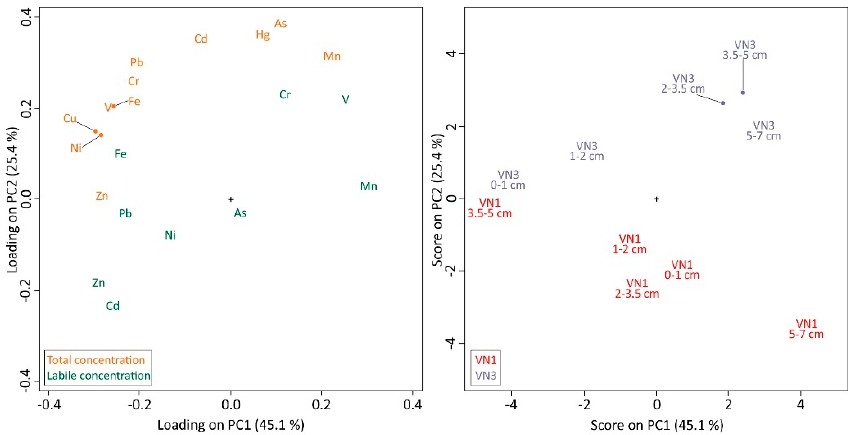
Figure 2. Score and loading plots resuming the results of principal component analysis (PCA) performed on total and labile metal(loid) concentrations is sediments at sites VN1 and VN3. Table 1. Metal(loid) concentrations in each level of the VN1 and VN3 sediment cores.